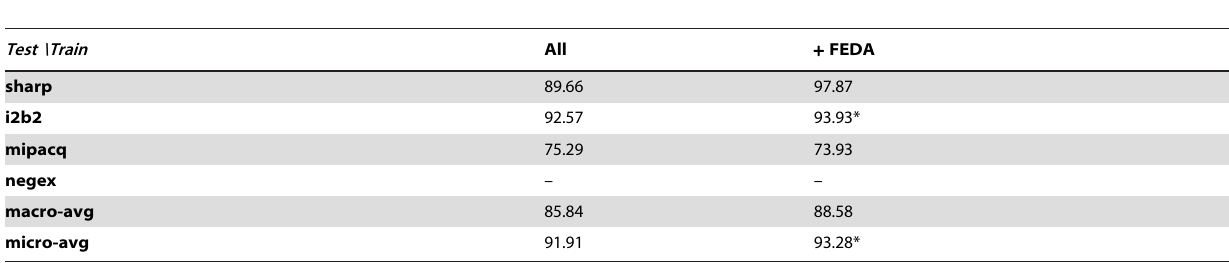
Table 5. Average F-score with and without frustratingly easy domain adaptation (FEDA).